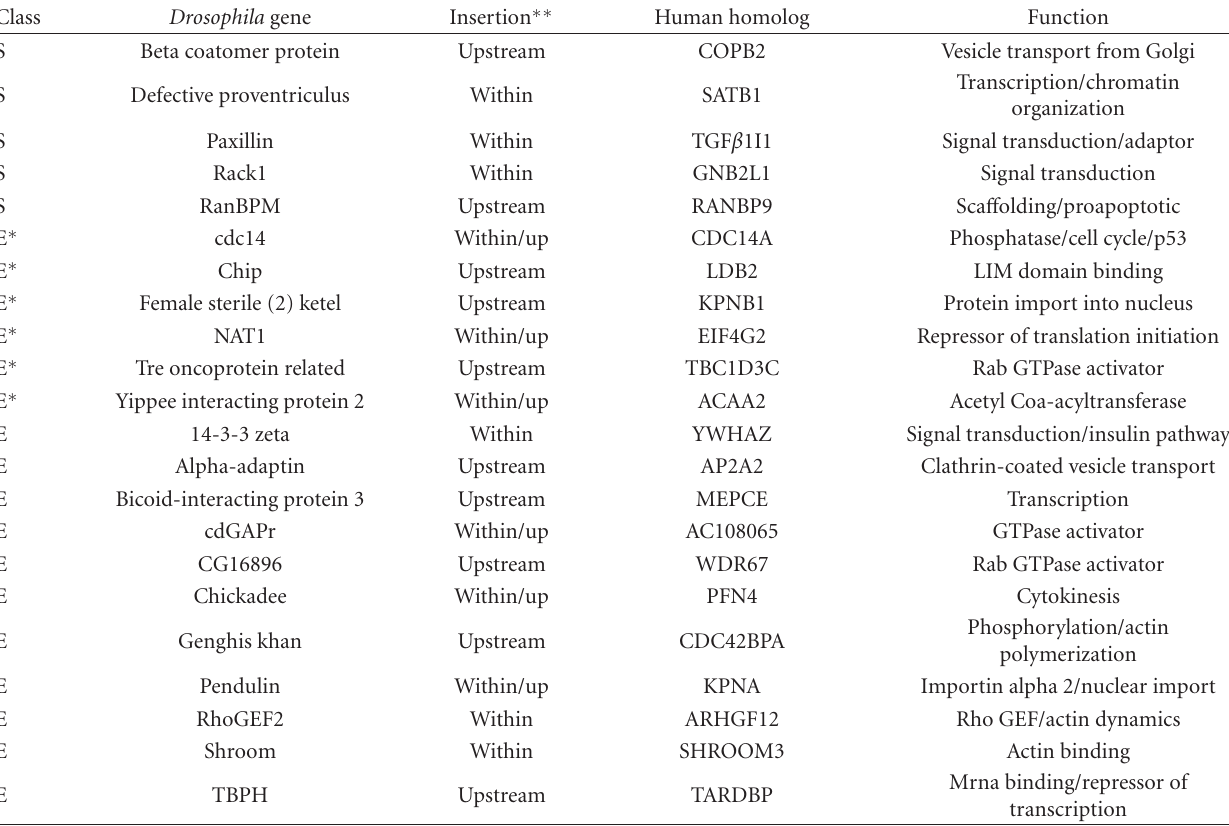
Table 2: EP Line (second chromosome) Genetic Screen: Suppressors (S) and Enhancers (E) of the GMR-R phenotype.